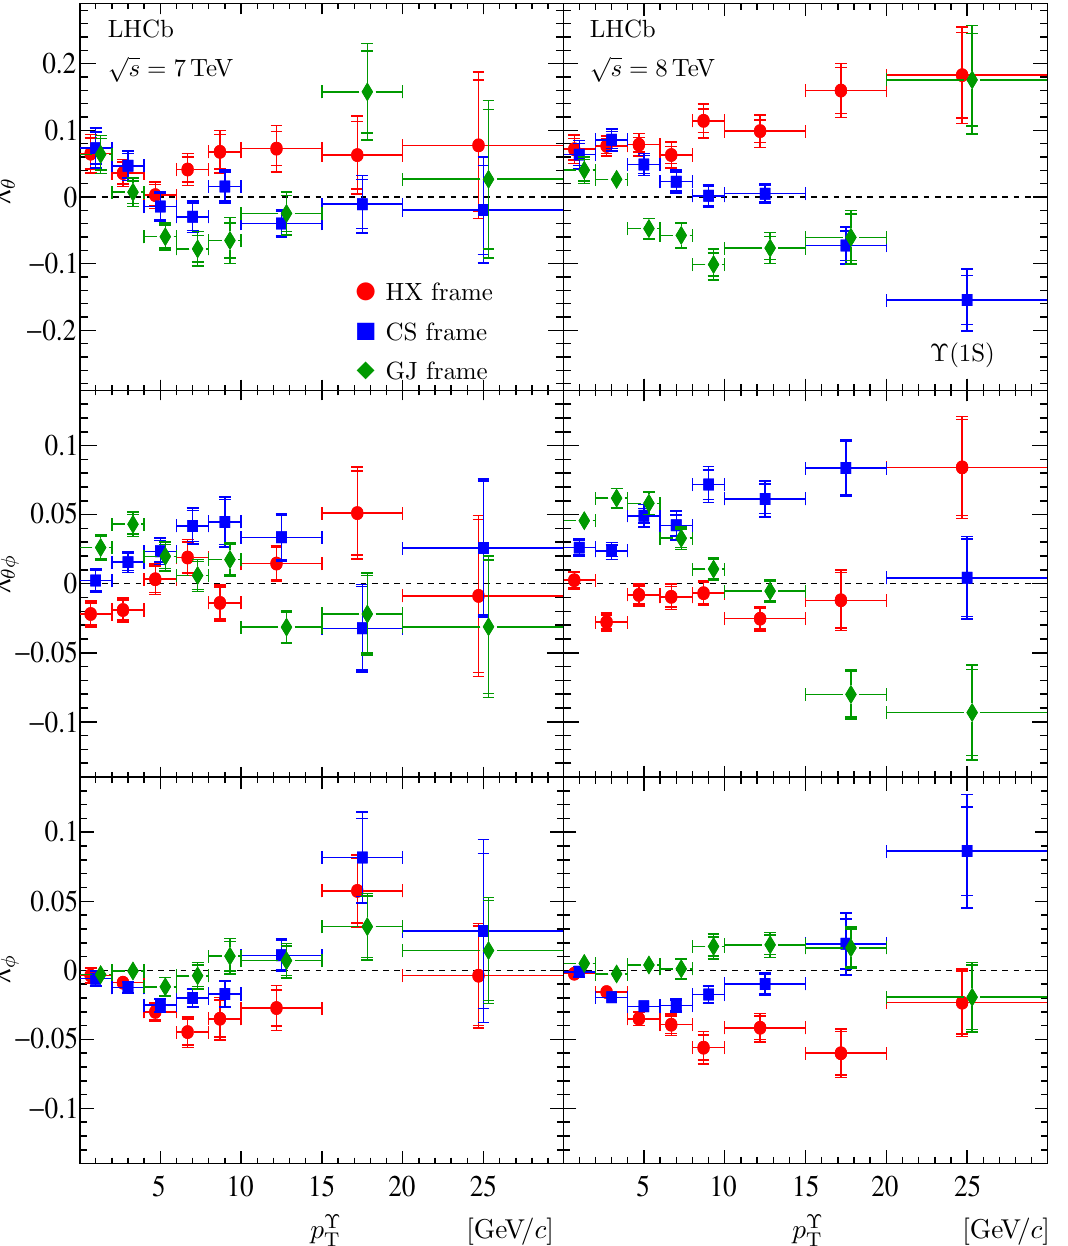
Figure 12 . The polarization parameters (top) (cid:21) (cid:18) , (middle) (cid:21) (cid:18)(cid:30) and (bottom) (cid:21) (cid:30) , for (cid:7)(1S) mesons as a function of p (cid:7) , for the rapidity range 2 : 2 < y (cid:7) < 4 : 5, for data collected at (left) T p and (right) s = 8 TeV. The results for the HX, CS and GJ frames are shown with red circles, blue squares and green diamonds, respectively. The inner error bars indicate the statistical uncertainty, whilst the outer error bars indicate the sum of the statistical and systematic uncertainties added in quadrature. Some data points are displaced from the bin centers to improve